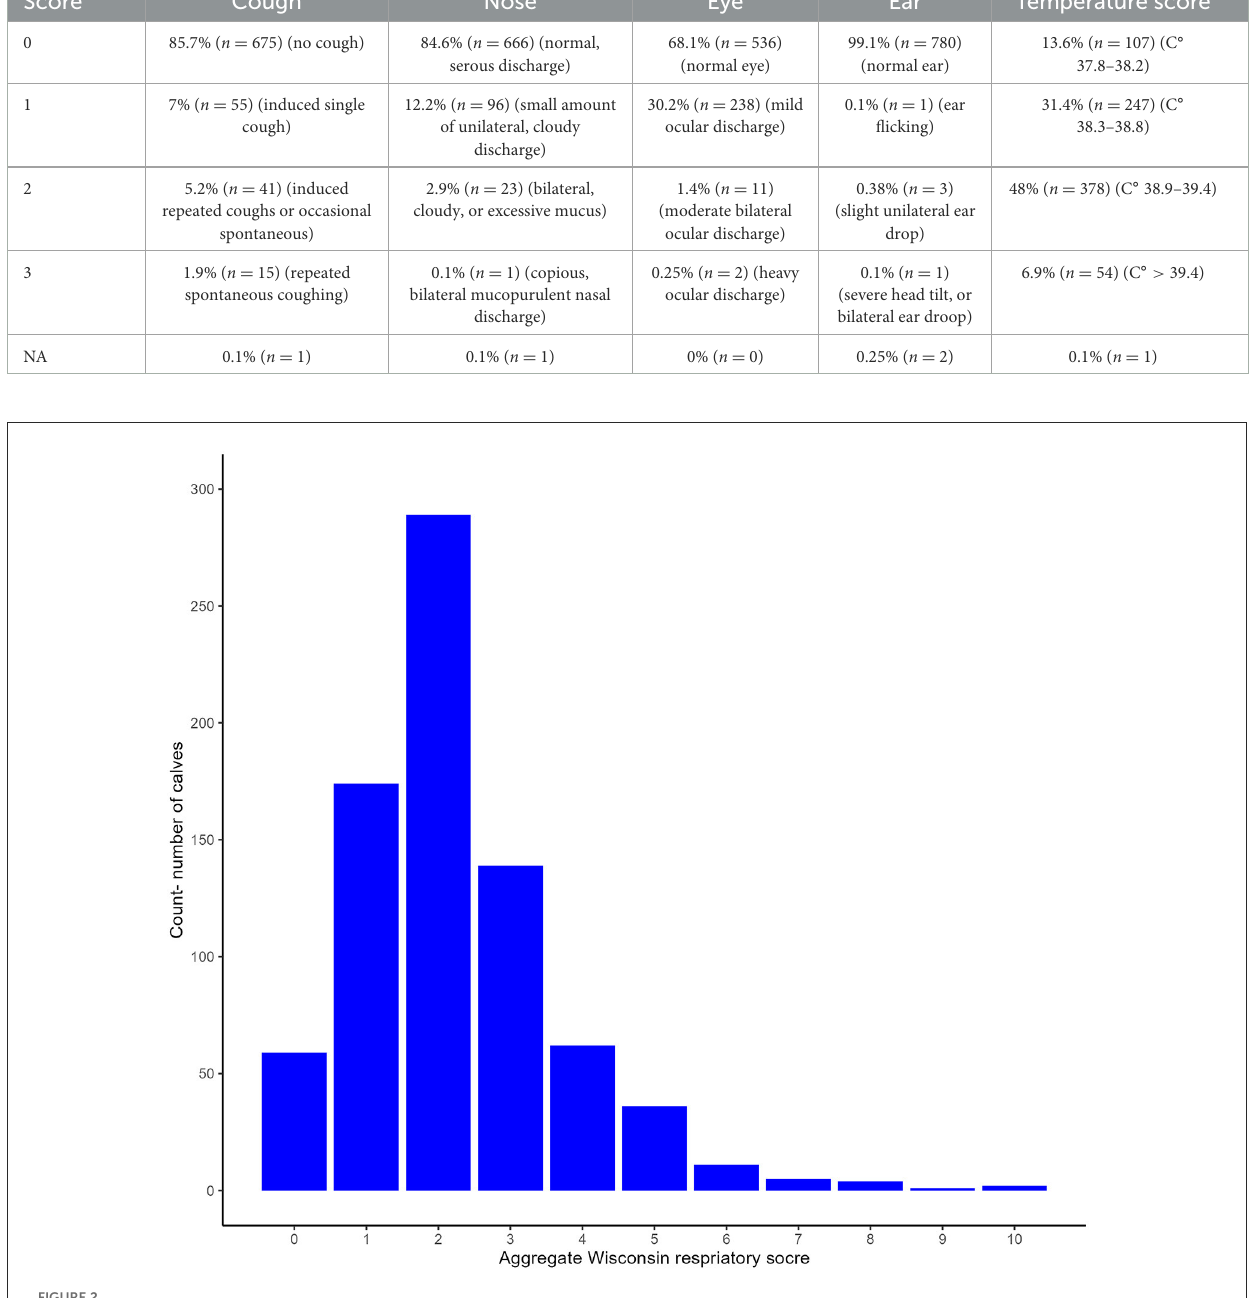
FIGURE2 Histogram of the frequency of each aggregate Wisconsin Respiratory score.